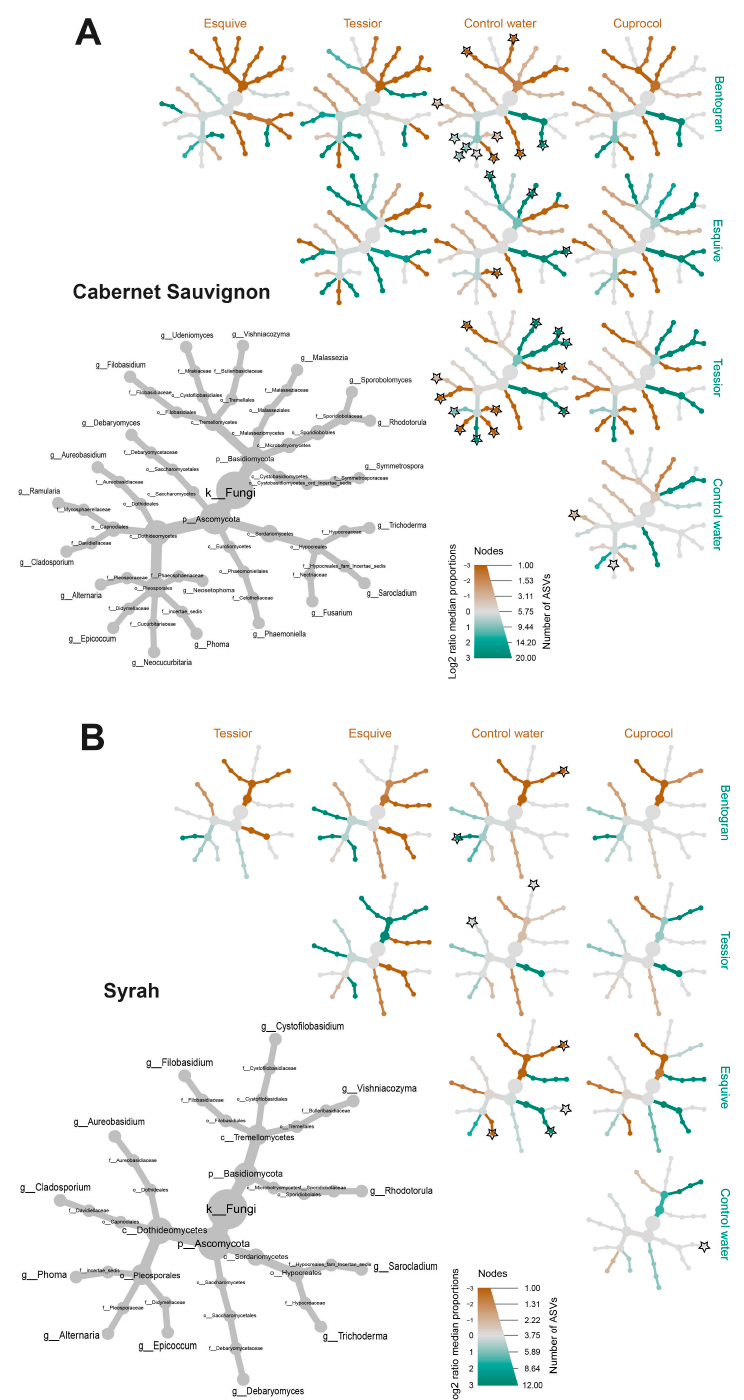
Figure 8. Differential heat tree matrices depicting changes in taxon abundance between different pruning wound protection product treatments (Bentogran, control water, Cuprocol, Esquive and Tessior) in Cabernet Sauvignon ( A ) and Syrah ( B ) from the DISAFA vineyard, represented in the dataset at a relative abundance (RA) > 0.1%. The smaller cladograms show pairwise comparisons between each treatment, with the color illustrating the log2 fold change: a green node indicates a lower abundance of the taxon in the treatment group on the abscissa than in the treatment group on the ordinate. A brown node indicates the opposite. A black star on a node represents statistically significant differences between treatments according to DeSeq2 ( p <